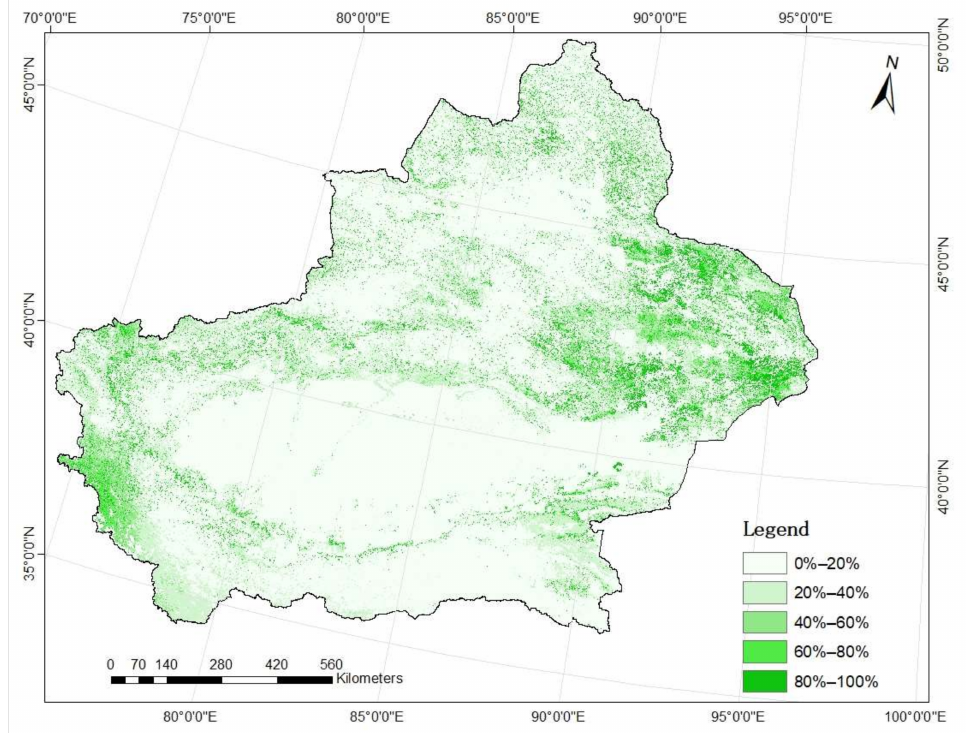
Figure 8. Contributions of climate change to NPP variations in Xinjiang from 2000 to